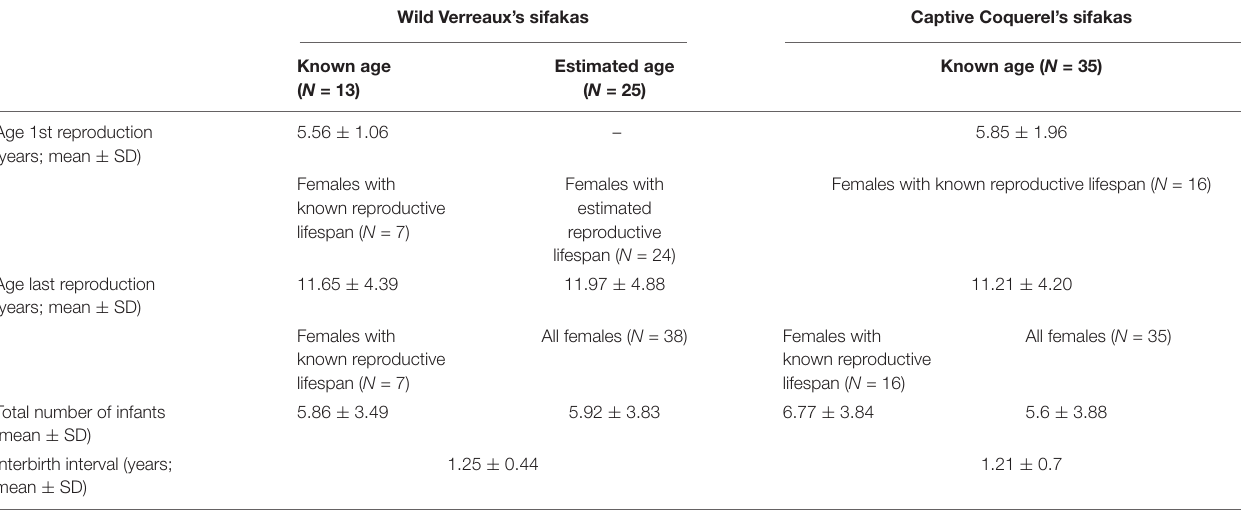
TABLE 1 | Overview of life-history milestones and sample sizes of wild Verreaux’s and captive Coquerel’s